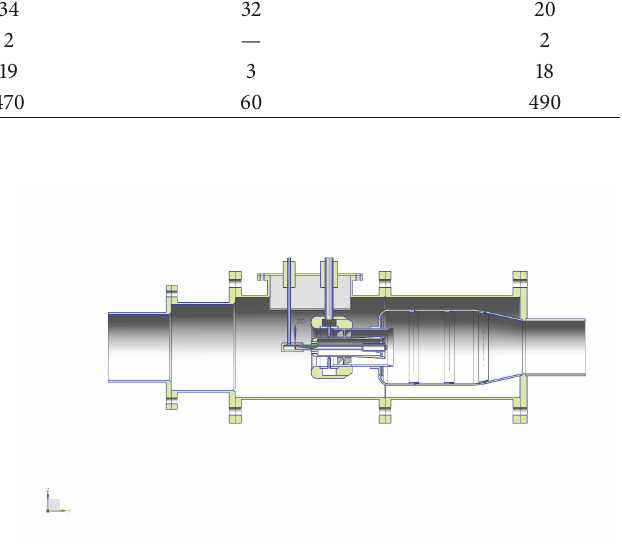
Figure 1: Simulated combustion